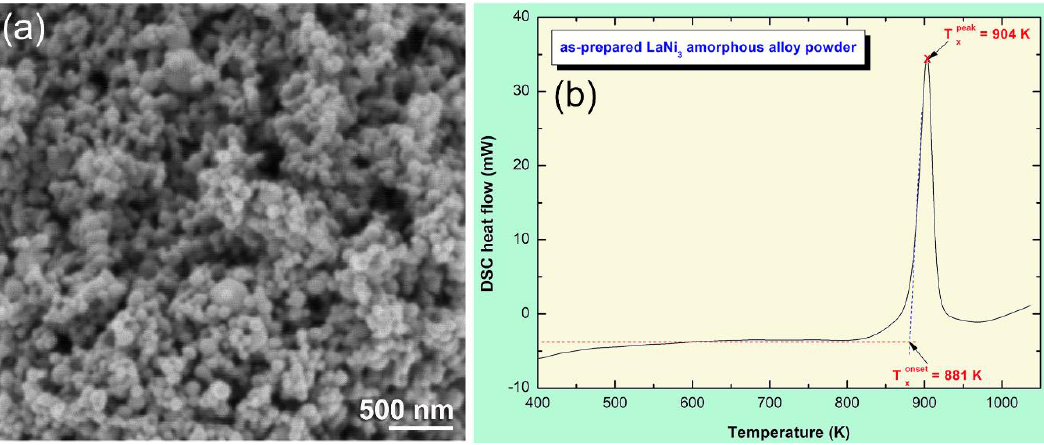
Figure 4. ( a ) FE-SEM micrograph and ( b ) DSC thermogram of a-LaNi 3 powders obtained after 100 h of MD time.